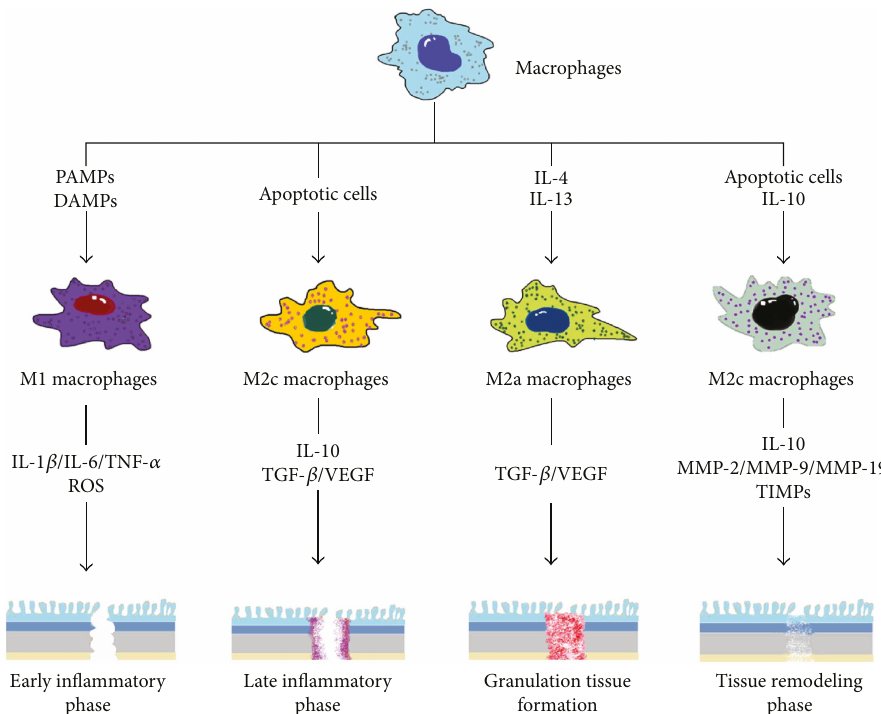
Figure 1: Polarization of macrophages in normal healing of anastomosis. Inactivated macrophages can be stimulated by various stimuli (e.g., PAMP, DAMP/IL-4, and IL-13/apoptotic cell) and polarize into M1- or M2- (M2a, M2c) type macrophages during di ff erent phases of normal anastomotic healing. Di ff erentiated macrophages express a variety of cytokines (e.g., IL-1 β , IL-6, IL-10, and TNF- α ), growth factors (e.g., VEGF), and enzymes (MMPs). These biochemical substances acting upon tissues contribute to tissue repair and remodeling. PAMP: pathogen-associated modifying patterns; DAMP: damage-associated modifying patterns; IL: interleukin; TNF- α : tumor necrosis factor- α ; VEGF: vascular endothelial growth factor; MMPs: matrix